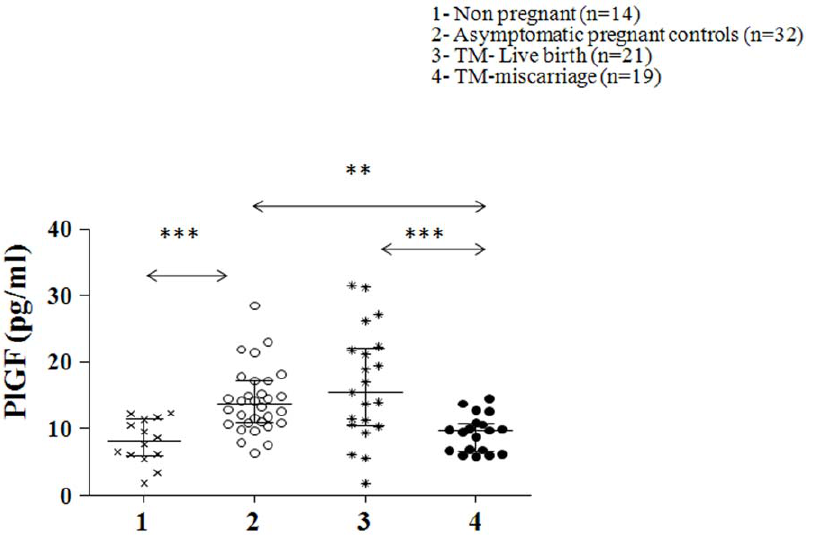
Figure 2. Scatter plot of circulating levels of serum placental growth factor (PlGF) in the different groups of women with median and interquartile range. Group 1 (non-pregnant women, n=14), group 2 (normal pregnant women, n=32), group 3 (threatened miscarriage patients with a live birth outcome, n=21) and group 4 (threatened miscarriage patients with a subsequent miscarriage, n=19). General linear analysis of variance was carried out to study the statistical significance between the groups with posthoc tests. P , 0.001=***, P , 0.01=**.